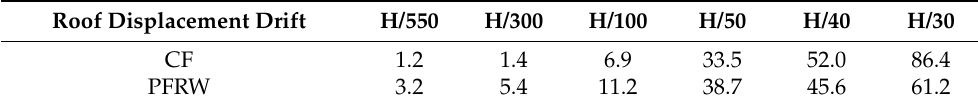
Table 4. Largest residual deformation observed at selected load cycles (unit: mm). Roof Displacement